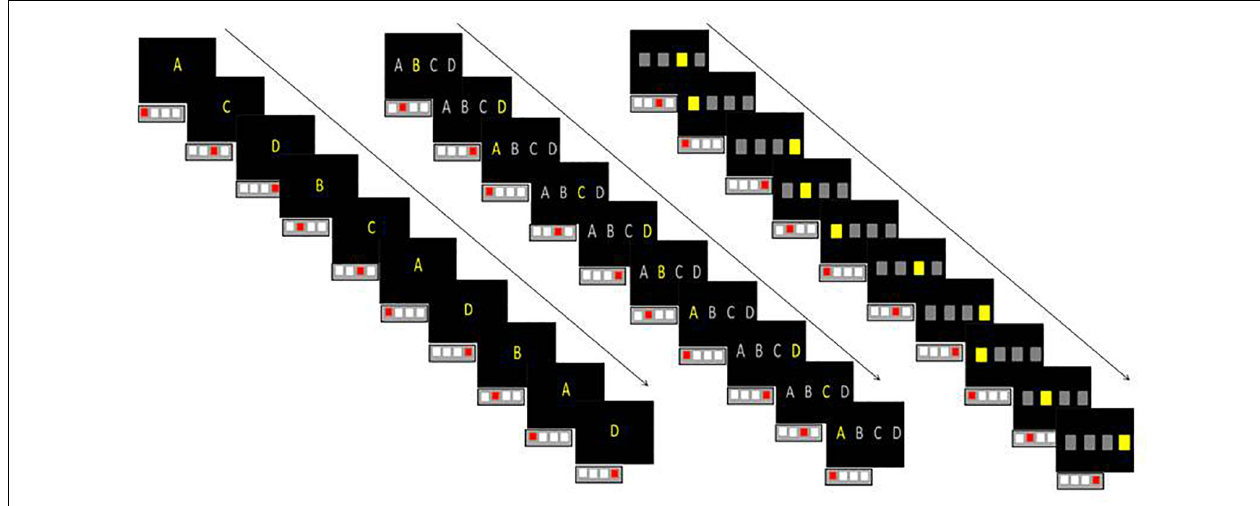
FIGURE 1 | Schematic representation of the three conditions (Letter on the left, Visuospatial + Letter in the middle, and Visuospatial on the right) when displaying the three sequences with the corresponding motor response schematized by a keyboard with four keys.